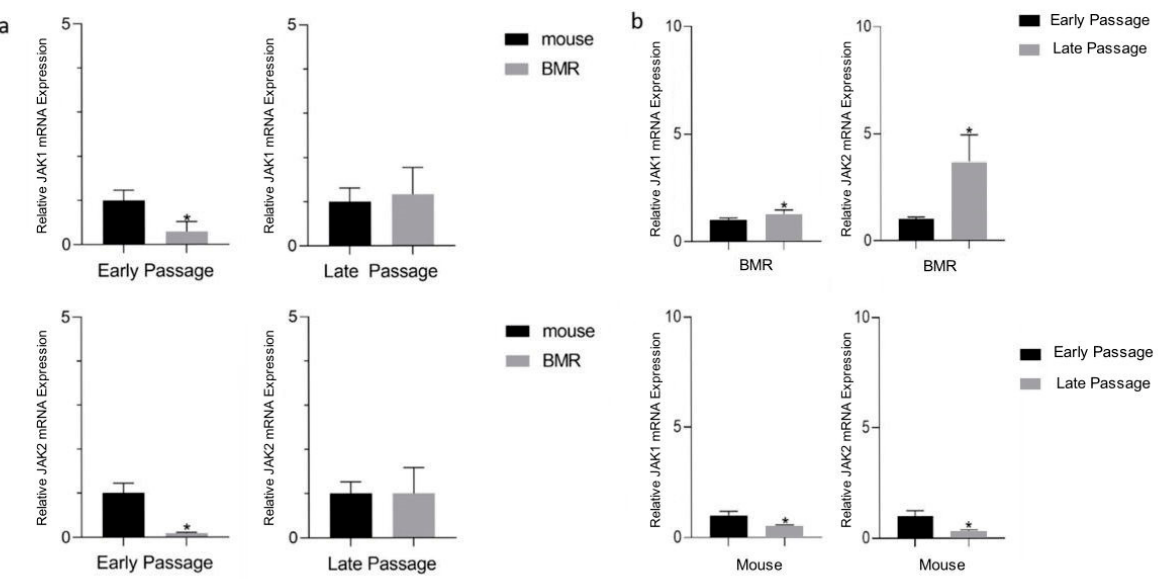
Figure 2. Jak1 and Jak2 mRNA expressions are increased in BMRs during replicative senescence. ( a ) Jak1 and Jak gene expressions were compared between mouse and BMR cells either in early or late passages. ( b ) Jak1 and Jak2 gene expressions were compared in early and late passage cells in either mice or BMRs. The expression levels were quantified with qRT-PCR. The p -value was calculated with a Mann–Whitney test ( n = 3, * p < 0.05), and the standard deviation (SD) represents the mean expression values of three replicates.